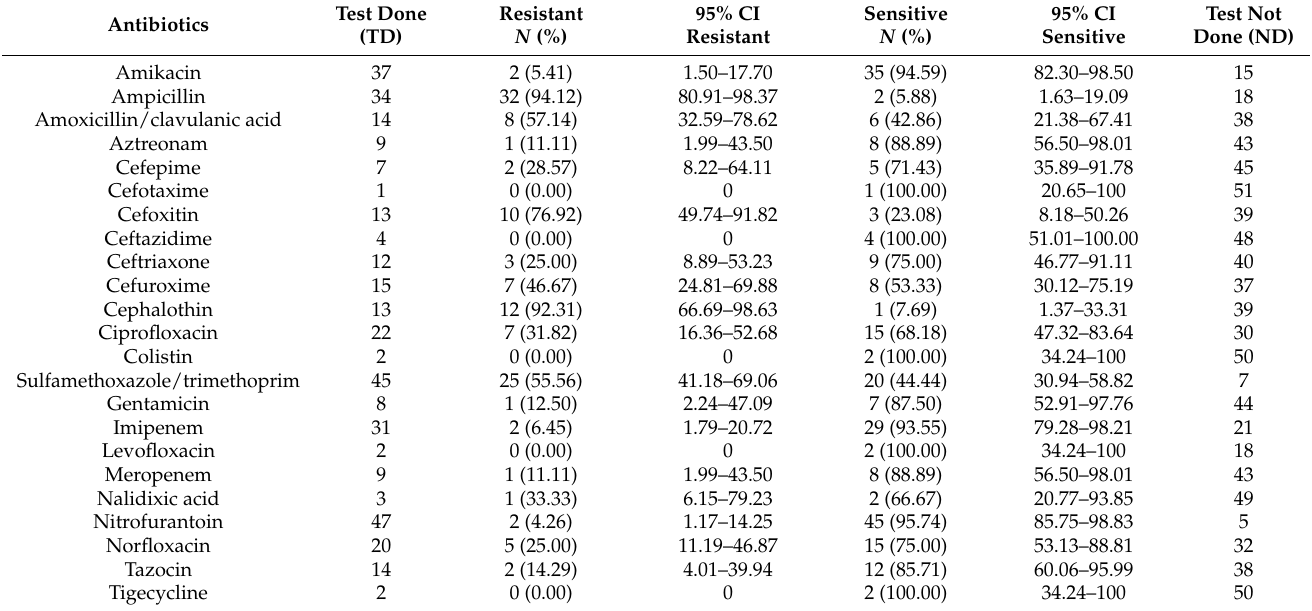
Table 2. Susceptibility pattern of E. coli in pediatric UTI patients .